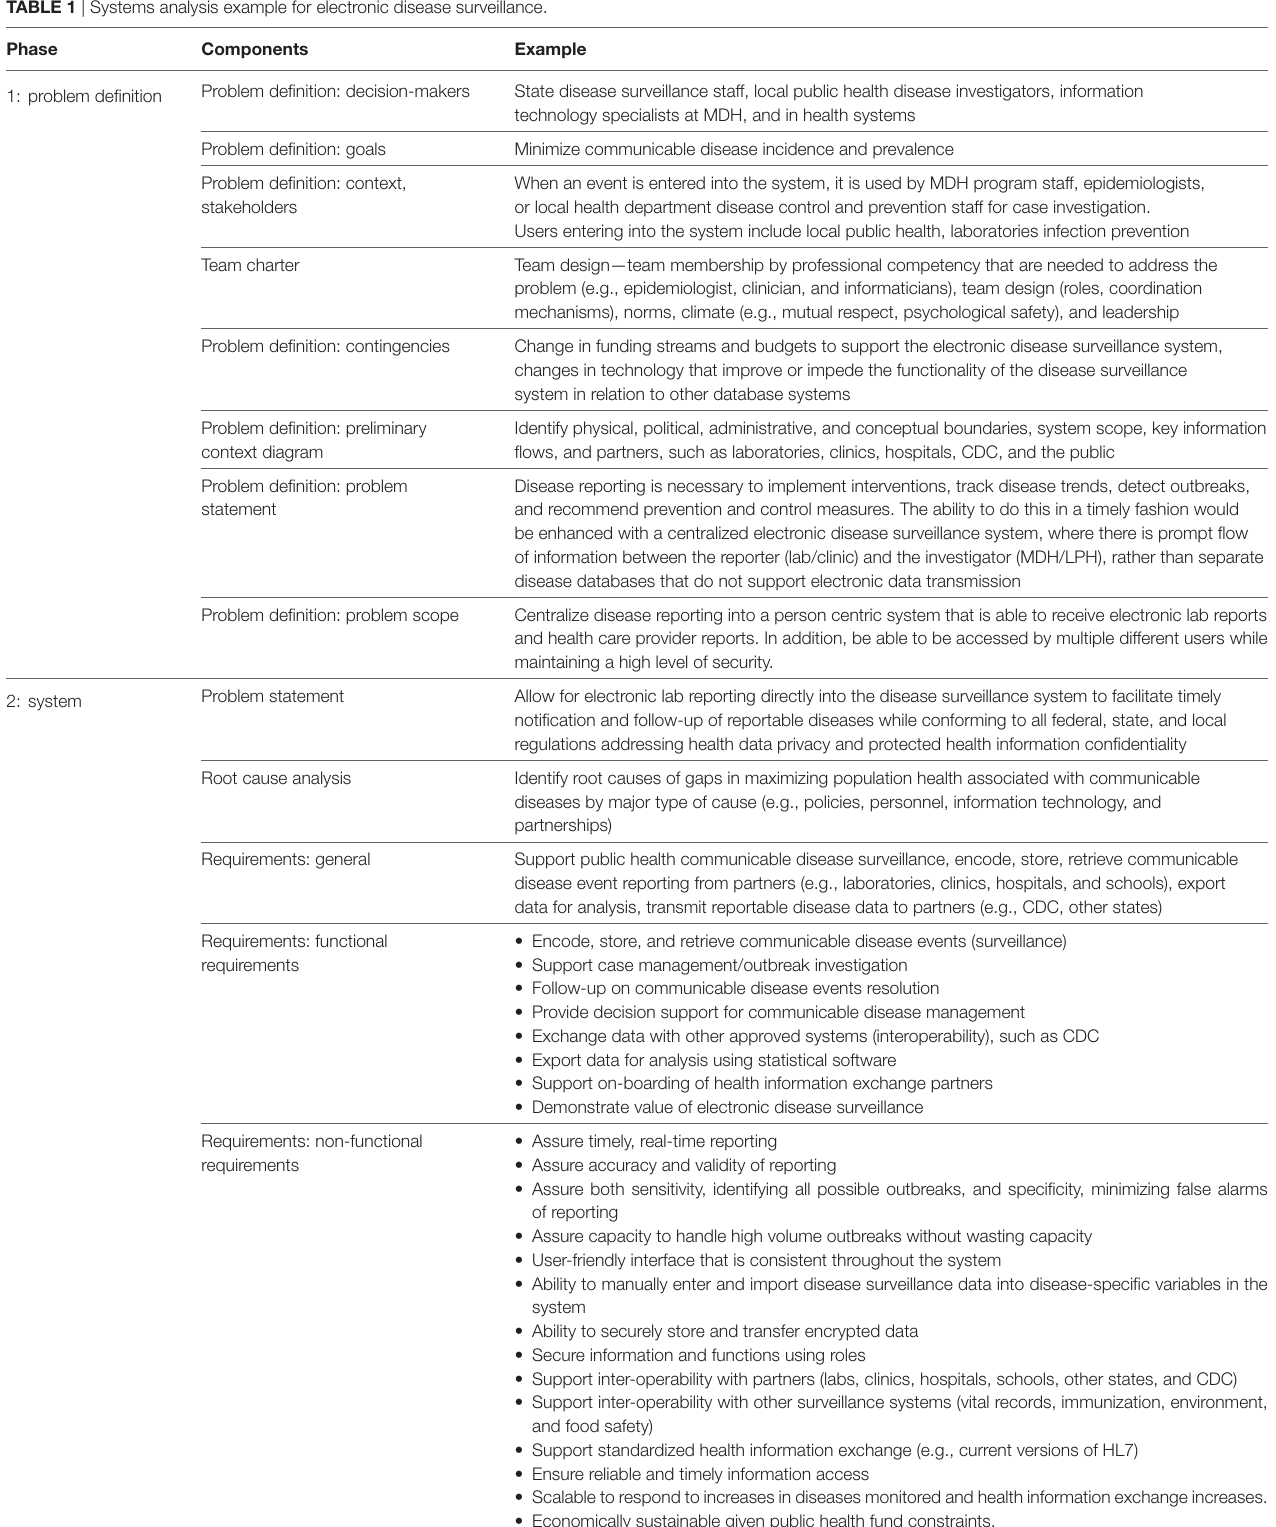
taBle 1 | Systems analysis example for electronic disease